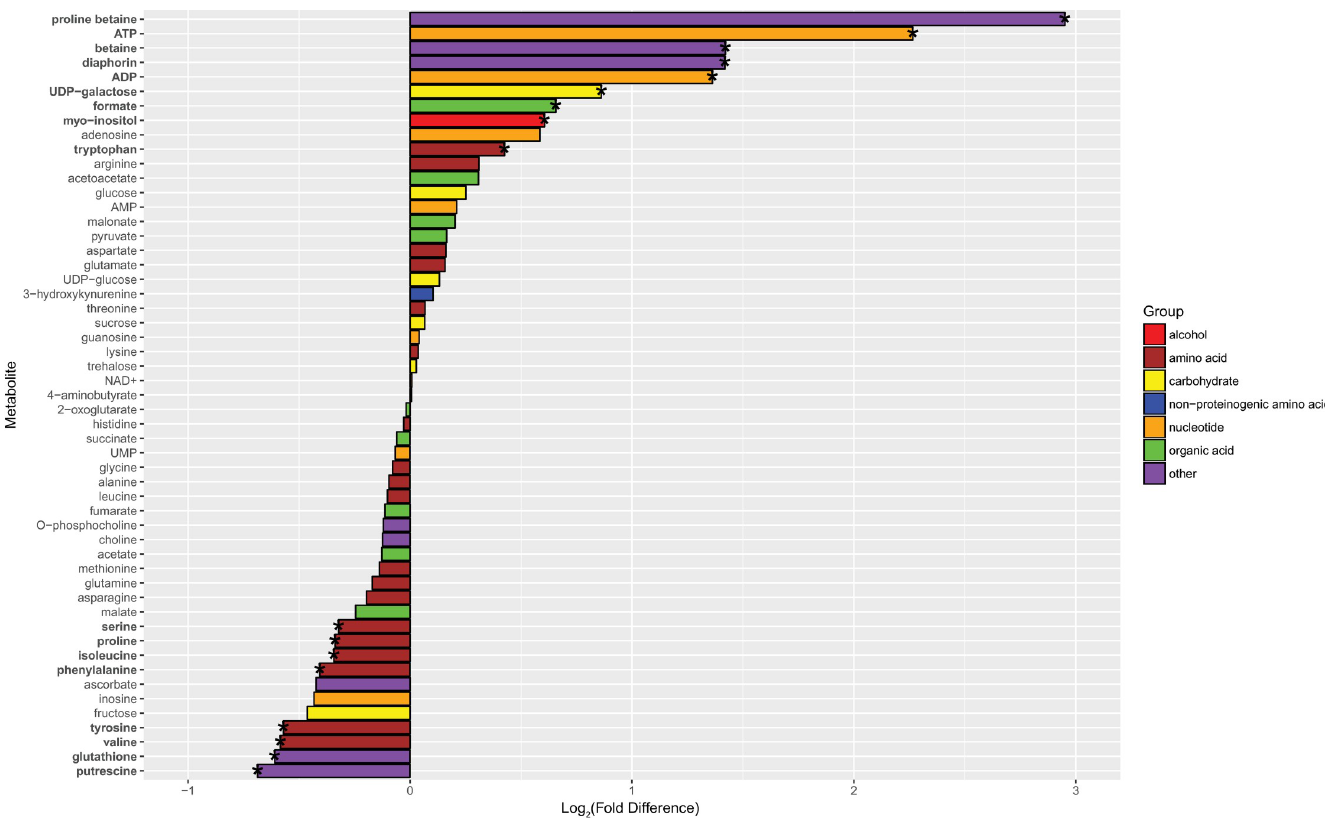
Fig 5. Metabolite log 2 -fold differences between control and CLas-exposed males. Positive fold differences indicate a higher concentration in CLas-exposed males, while negative fold differences indicate a higher concentration in control males. Metabolites in bold and corresponding bars with an asterisk are significantly differentially abundant between control and CLas-exposed males. Metabolites are colored by type of molecule.